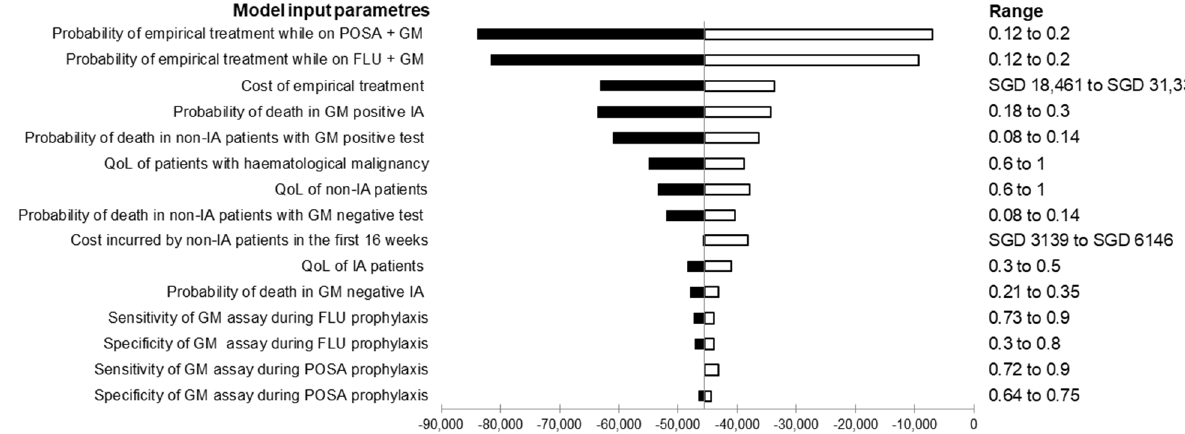
Figure 2. Tornado diagram representing deterministic sensitivity analysis of routine galactomannan surveillance in patients receiving non-mould-active prophylaxis compared to mould-active prophylaxis. Each horizontal bar in the tornado diagram represented the incremental cost-effectiveness ratio (ICER) generated from a range of values evaluated for each parameter. The vertical line represents ICER determined from the base-case analysis. FLU: fluconazole, GM: galactomannan, IA: invasive aspergillosis, IFI: invasive fungal infection, POSA: posaconazole, QoL: quality of life. Table 4. Total cost, effectiveness, and incremental cost-effectiveness ratio when the sensitivity of serum galactomannan immunoassay decreased in patients receiving mould-active prophylaxis.